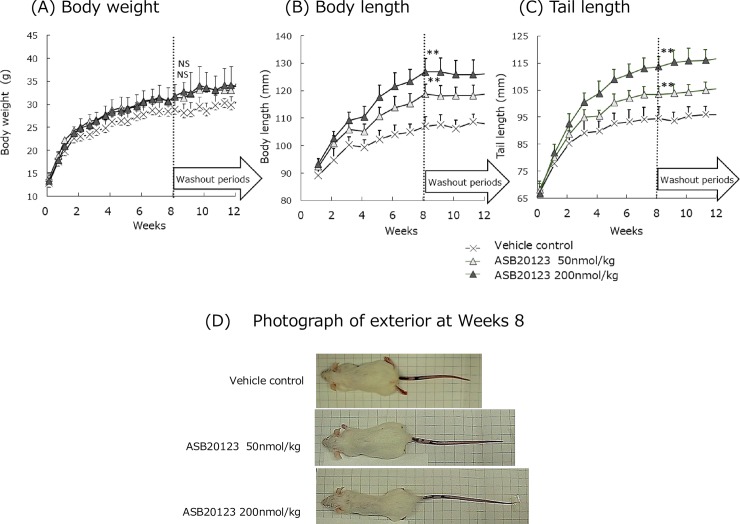
Growth curves of female juvenile ICR mice treated with ASB20123 sc during the 8 weeks of the dosing period and the 4 weeks of the washout period.Body weight (A), body length (B) and tail length (C) data are shown in the upper panels, and the photographs in the lower panel represent the gross appearance of mice at Day 56 (D). Each value represents the mean ± SD of 10 (for the dosing period) or 5 mice (for the washout period). NS: not significant (p > 0.05), *: significant difference (p < 0.05) compared to the control group using Dunnett’s test.